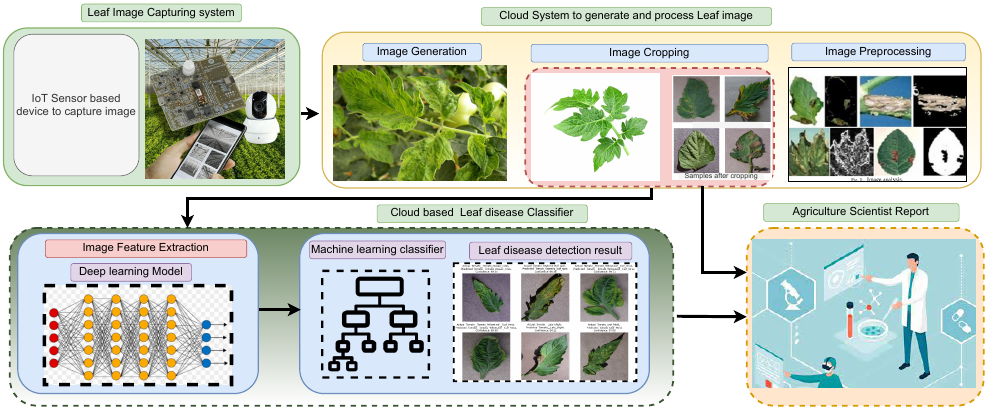
Figure 20. Cloud based Leaf disease